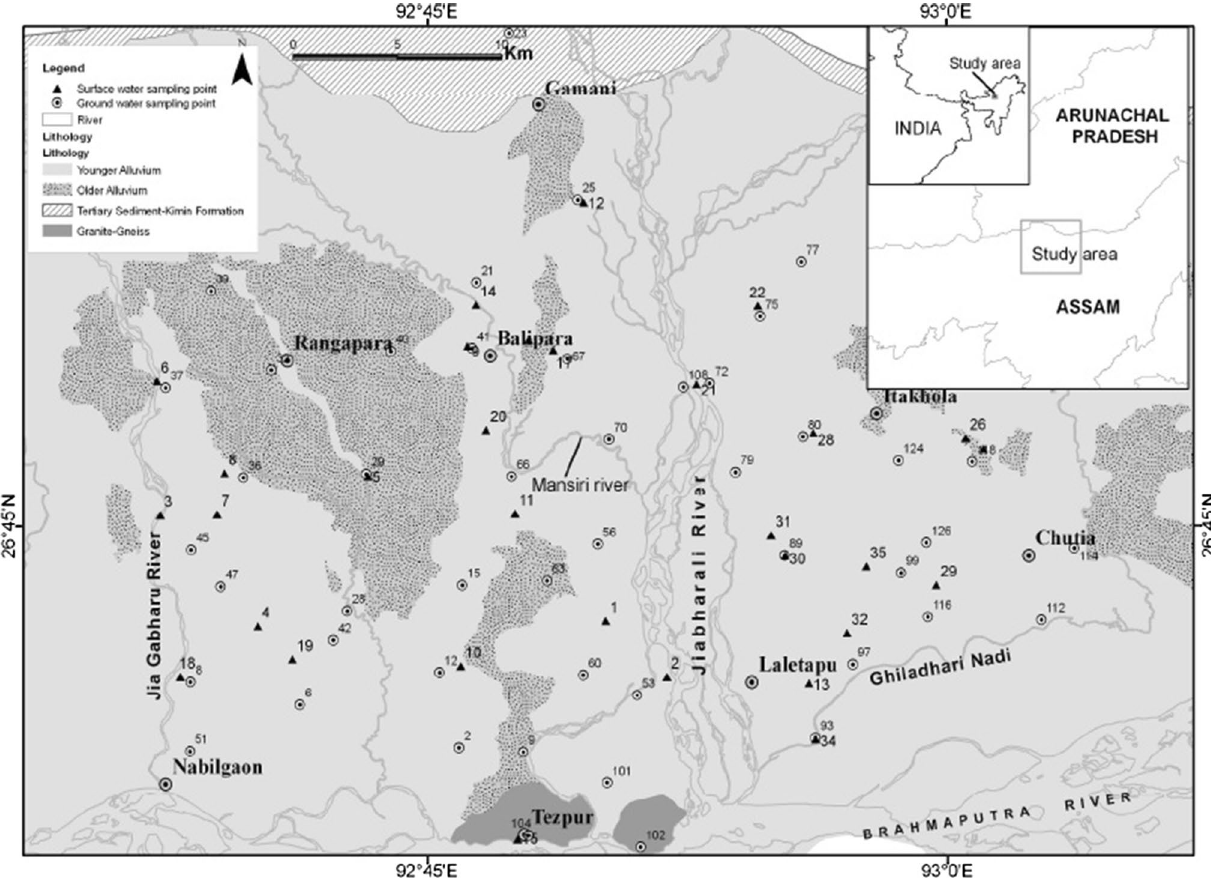
Fig. 1 The selected ground and surface water sampling points of the study area (Khound et al.